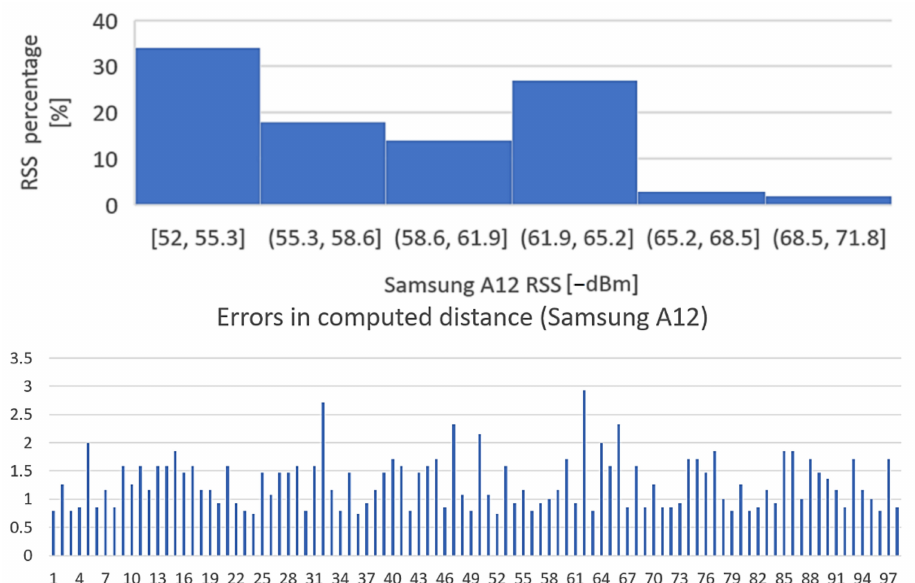
Figure 22. Variation in signal strength for fixed position of mobile station, LoS, d = 1m. Equipment: Samsung Galaxy